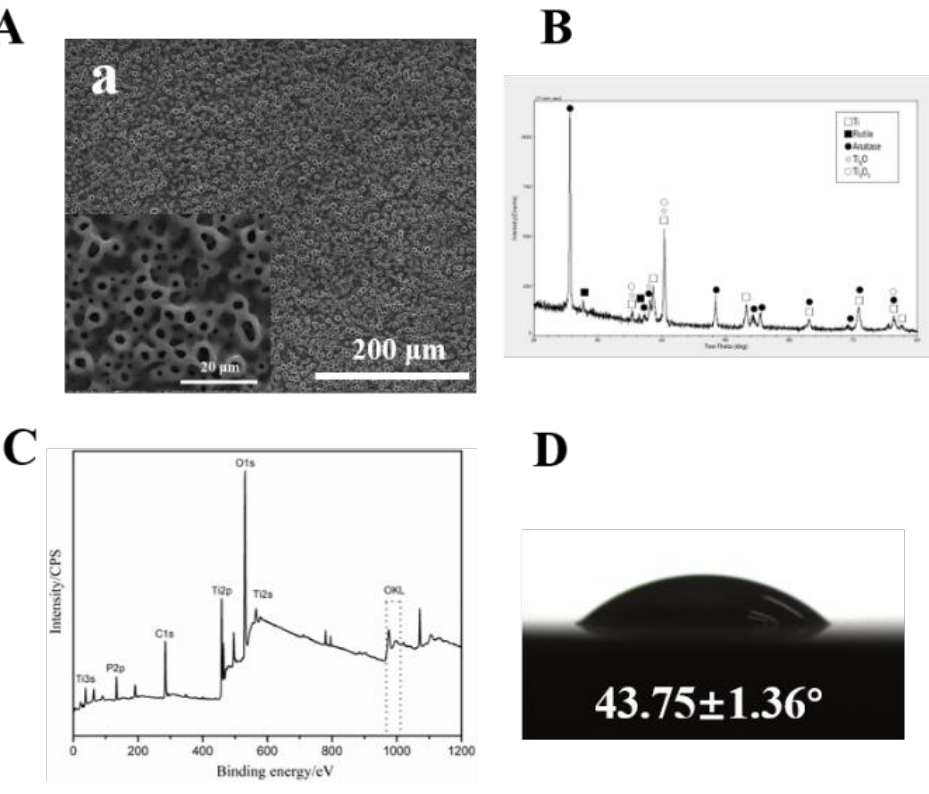
Figure 1. Surface morphologies ( A ), XRD patterns ( B ), XPS survey spectrum ( C ), and digital photo- graph of water droplets of MAO coating ( D ).